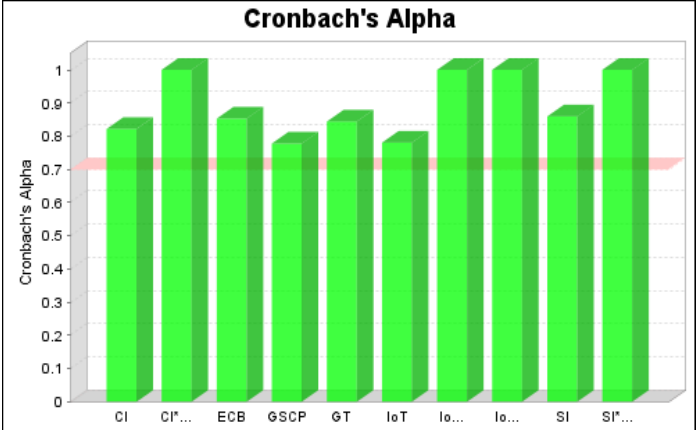
Figure 2. Cronbach’s Alpha values of research variables .